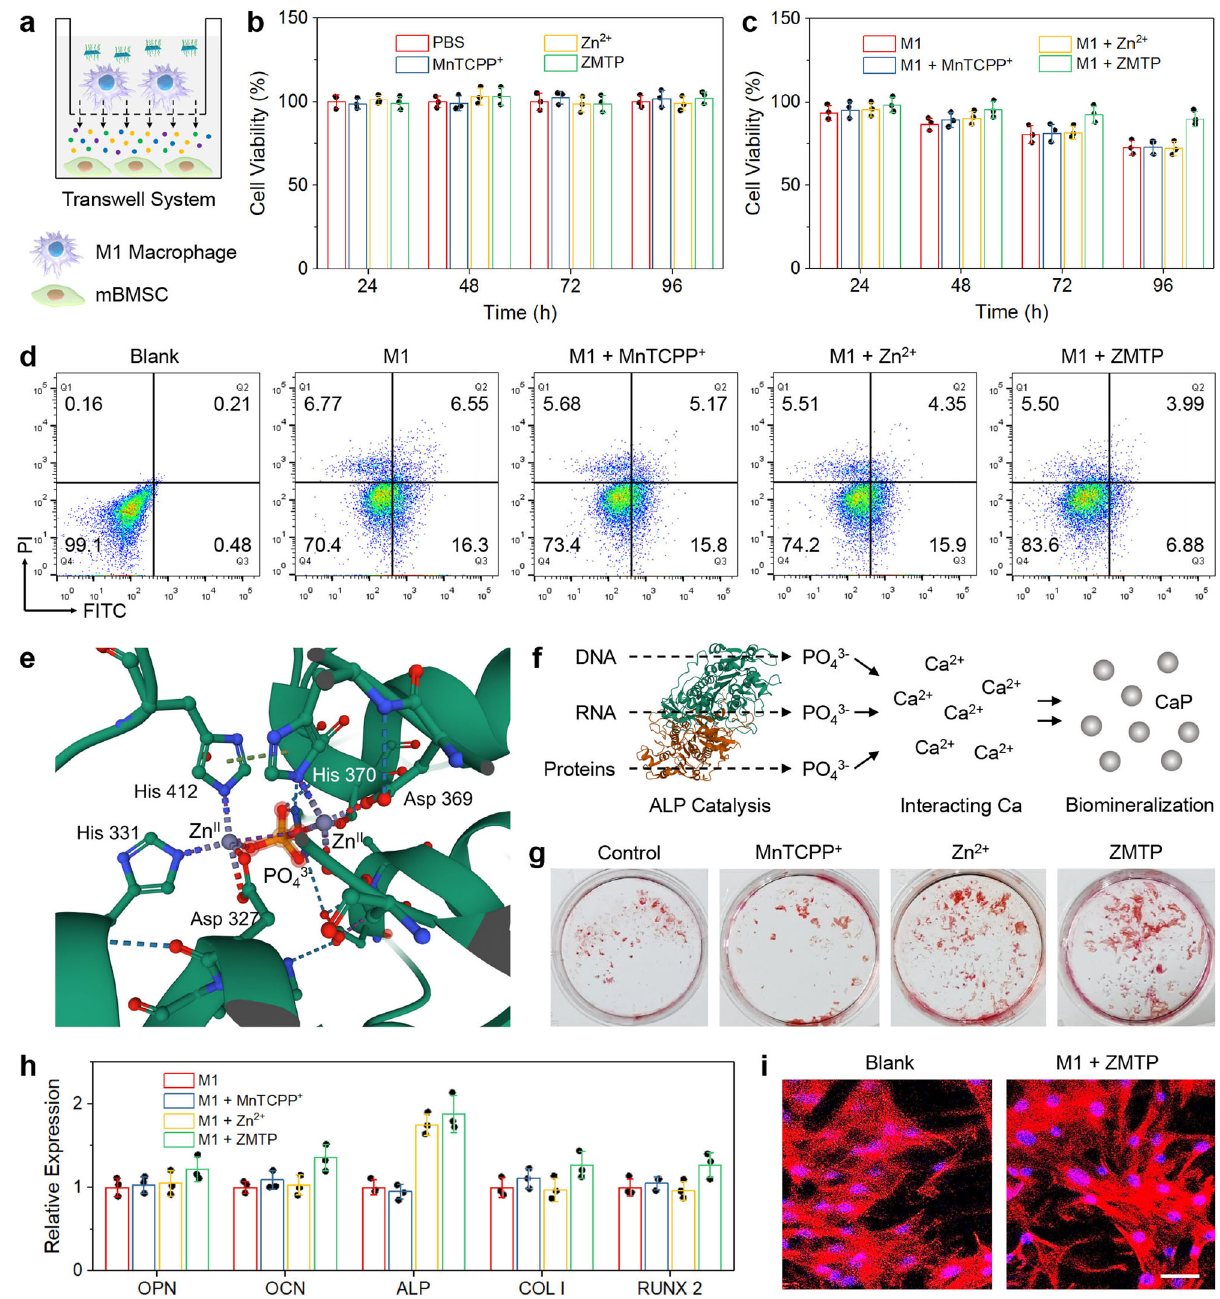
Fig. 6 Osteogenic differentiation promoted by ZMTP nanosheets. a Experimental setup for the transwell system. Chemicals can be exchanged through the fi lter membrane. b Viabilities of mBMSCs after direct treatments with different chemicals/materials for varied time durations without M1 macrophage co-incubation. Data are expressed as means ± SD ( N = 3 independent experiments). c Viabilities of mBMSCs fi rst co-incubated with M1 macrophages then treated with different chemicals/materials for varied time durations in the transwell system. Data are expressed as means ± SD ( N = 3 independent experiments). d Flow cytometric analysis showing the change of apoptotic behaviors of mBMSCs co-incubated with M1 macrophages followed by treatments with different chemicals/materials for 48 h, representative of 3 independent experiments. Primary mBMSCs without M1 macrophage co- incubation and additional treatments were also used as a blank group. e Schematic of the coordination environment around the two Zn II active sites of ALP. One PO 4 3- is produced between the two Zn II sites. H atoms are also omitted. f Chemical mechanism for ALP-promoted biomineralization. ALP catalyzes the dephosphorylation of phosphate monoester substrates (DNA, RNA, proteins, and alkaloids) and the production of inorganic phosphate, which will react with biological Ca 2 + to form CaP (hydroxyapatite), promoting biomineralization. g Alizarin red S staining of mineralized nodules of mBMSCs after directly treatment with MnTCPP + , Zn 2 + or ZMTP for 20 days. A representative image of three replicates from each group is shown. h Expressions of the mRNAs of OPN, OCN, ALP, COL 1, and RUNX 2 in mBMSCs after different treatments for 20 days, quanti fi ed by RT-PCR. Data are expressed as means± SD ( N = 3 independent experiments). i CLSM images of mBMSCs demonstrating no distinct morphological change after co-incubation with M1 macrophages followed by treatment with ZMTP for 72 h. Rhodamine phalloidin and Hoechst were applied for stanning the skeleton and nuclei of cells, respectively. A representative image of three replicates from each group is shown. Scale bar, 100 μ m. Source data are provided as a Source Data fi le.